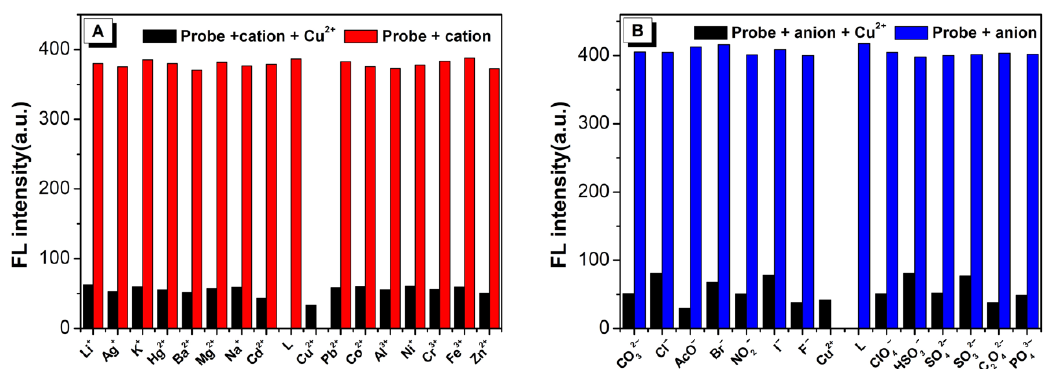
Figure 4. Bar diagram of the competitive experiments of various metal cations ( A ) and anions ( B ) on the fluorescence intensity of the probe/Cu 2+ complex in buffer solution.